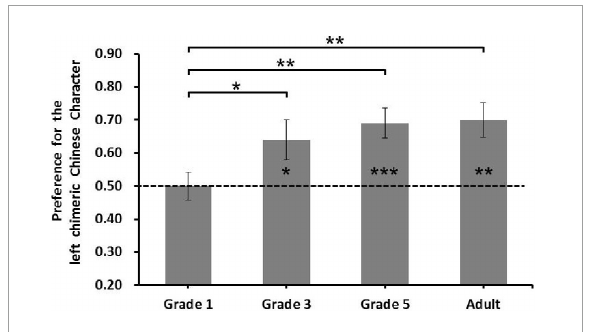
FIGURE4 The preference for the left chimeric Chinese character in Experiment 2. Error bars represent the standard error of the mean. * p < 0.05, ** p < 0.01, and *** p <